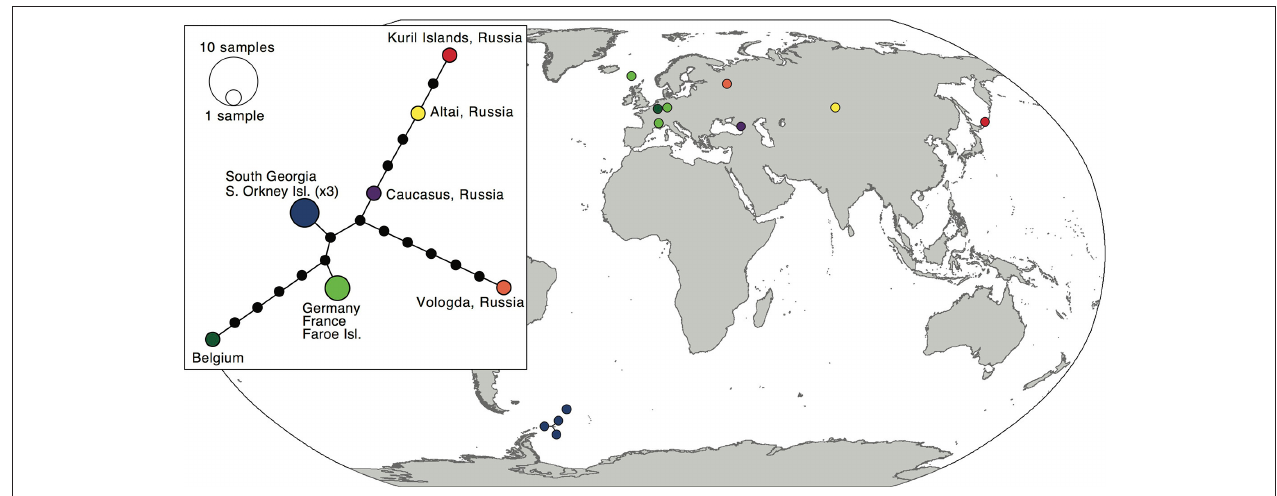
FIGURE 4 | Map and haplotype network of haplotypes within Schistidium rivulare . Map showing locations of different haplotypes within Schistidium rivulare . A TCS haplotype network is provided (see box) with corresponding colors to the haplotypes in the map. A legend with the number of individuals per haplotype is provided next to the haplotype